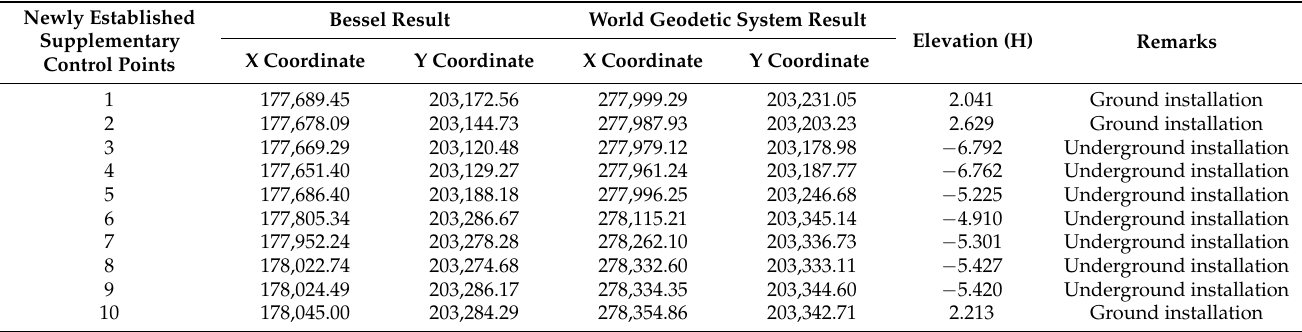
Table 4. Newly established supplementary control